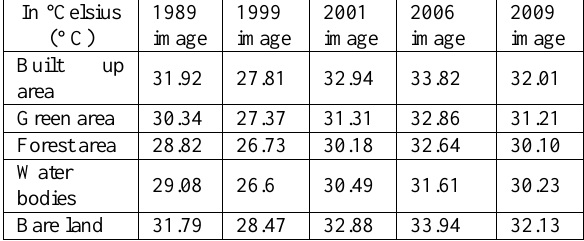
Table 2. Mean temperatures for each images Forest and water bodies recorded very similar mean temperatures, while the green sector had slightly higher mean temperatures than forest.